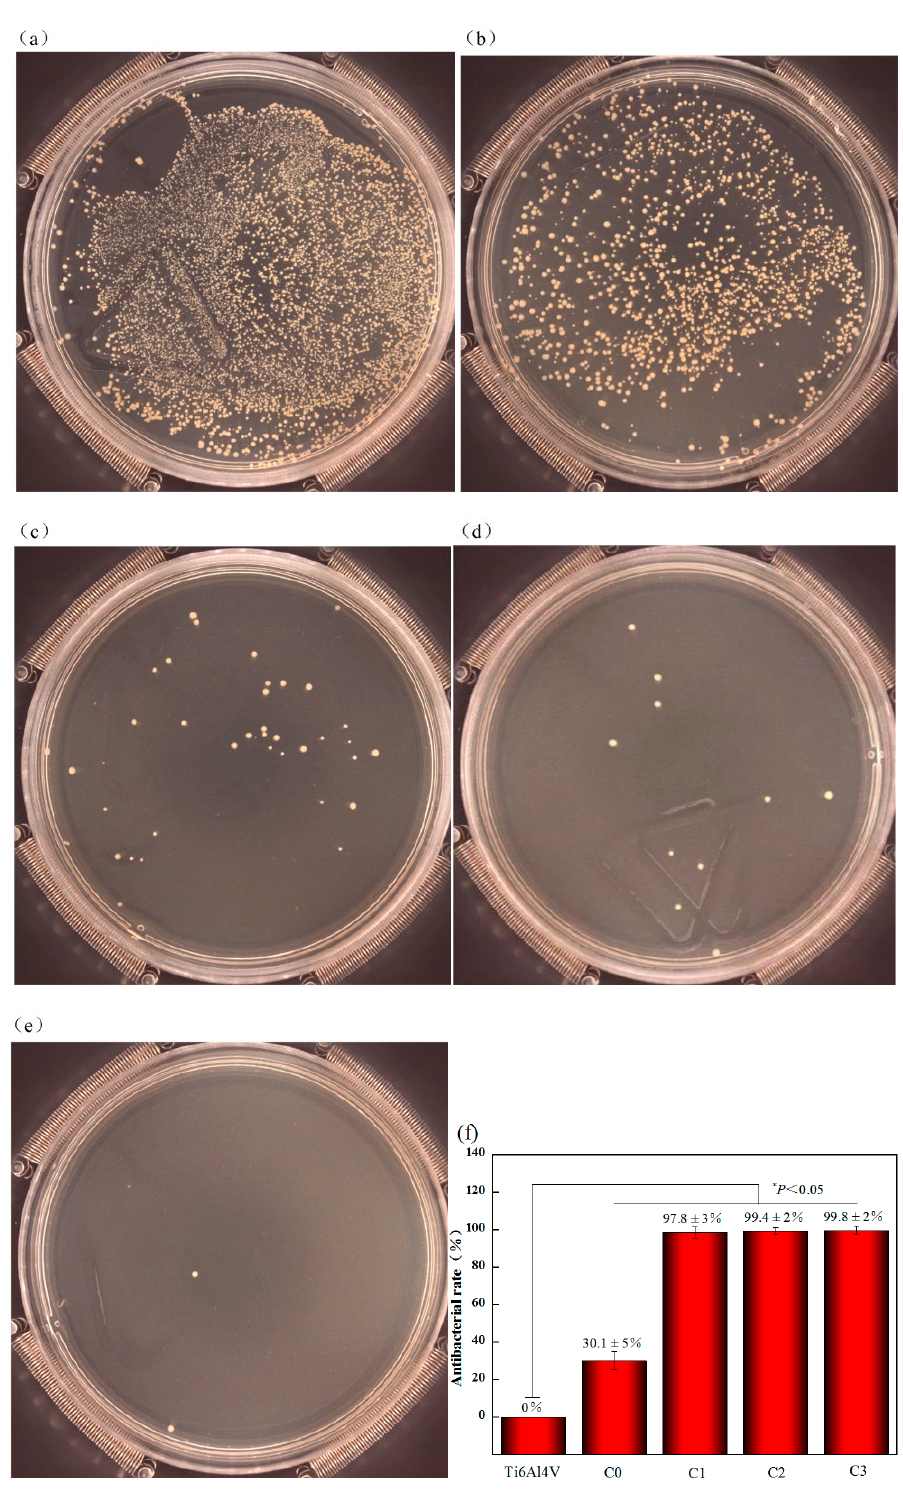
Figure 11. Live S. aureus after co-cultured with di ff erent samples at 37 ◦ C for 24 h: ( a ) Ti6Al4V, ( b ) C0, ( c ) C1, ( d ) C2, ( e ) C3 and ( f ) Antibacterial rates of all samples toward S. aureus .